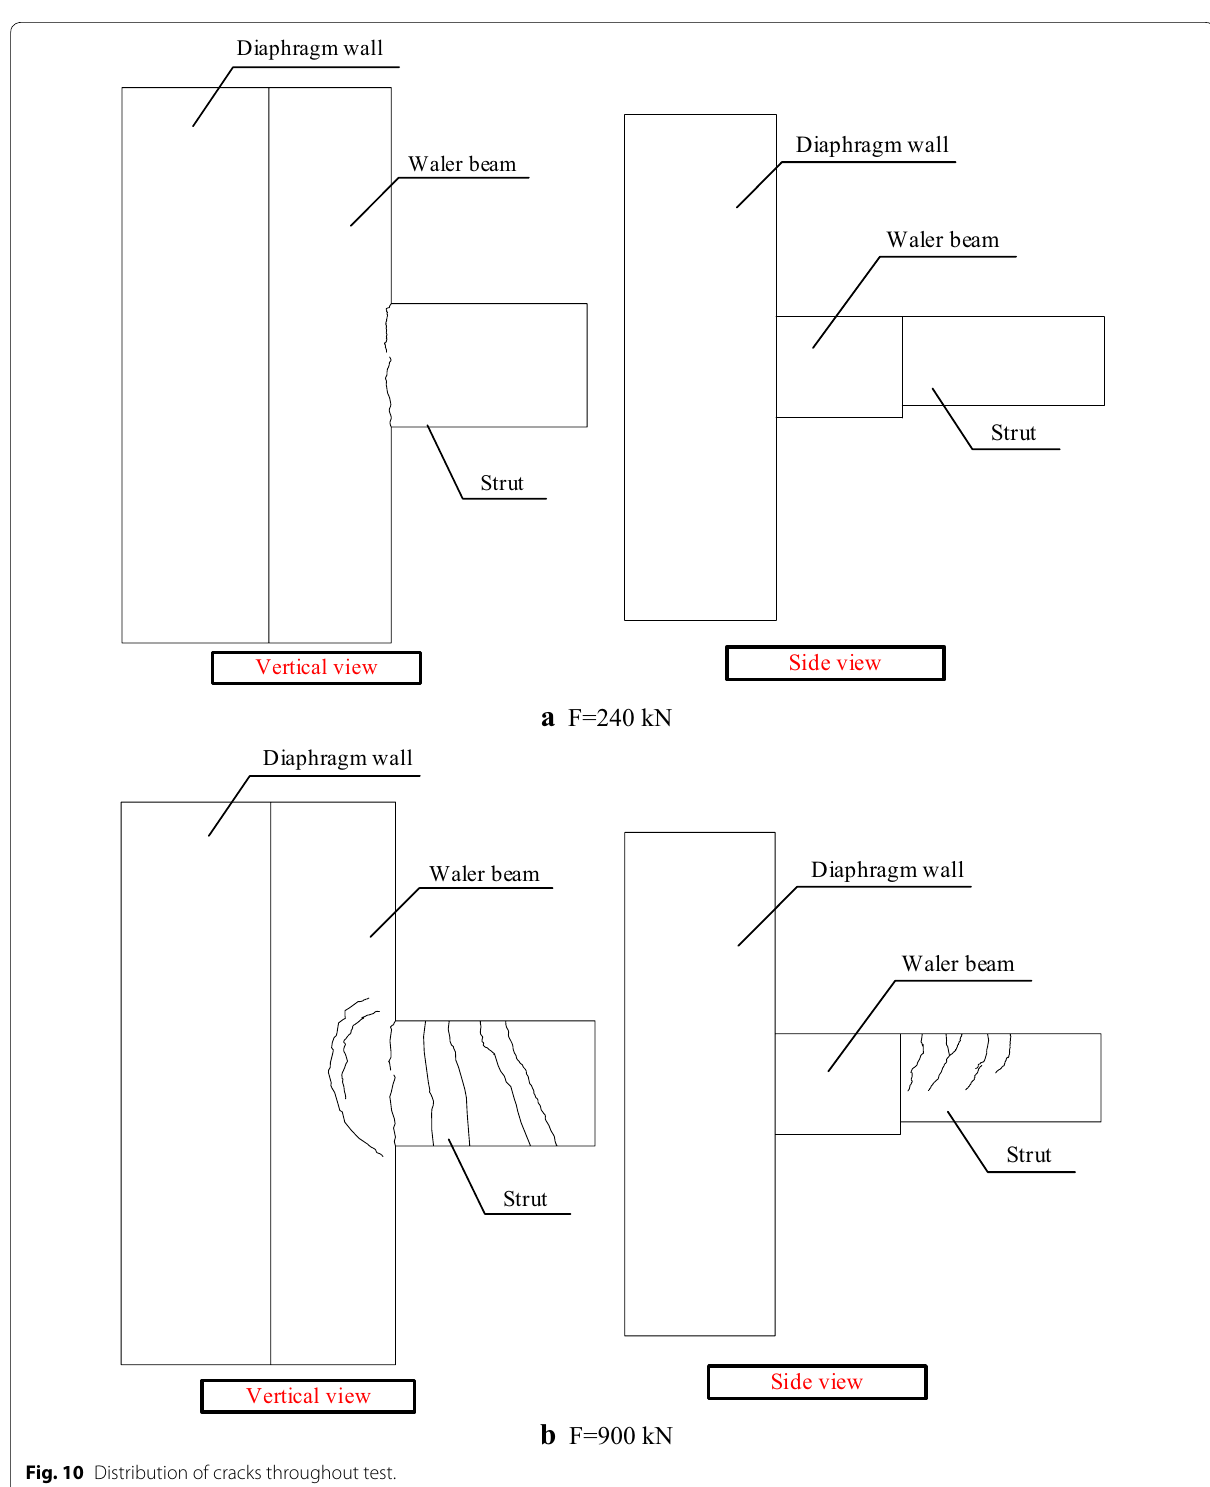
Fig. 10 Distribution of cracks throughout